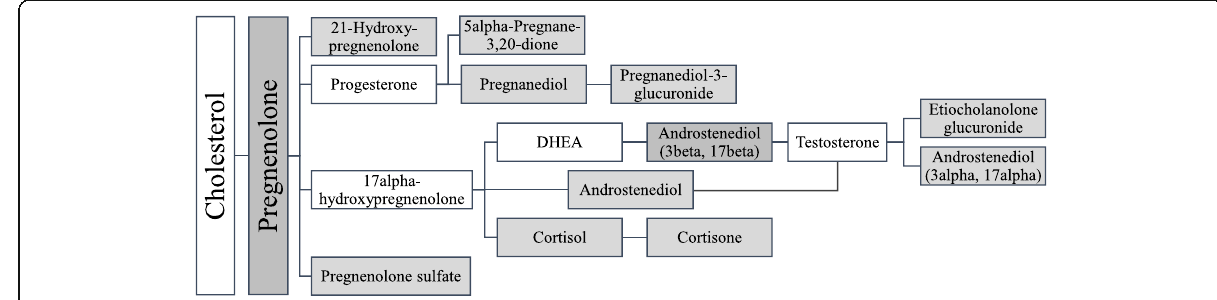
Fig. 4 A schematic diagram summarizing the biochemical relationships between steroid metabolites found significantly associated with high endurance (shaded boxes). This is based on the steroid hormone biosynthesis reference pathway (map00140) from the Kyoto Encyclopedia of Genes and Genomes (KEGG)